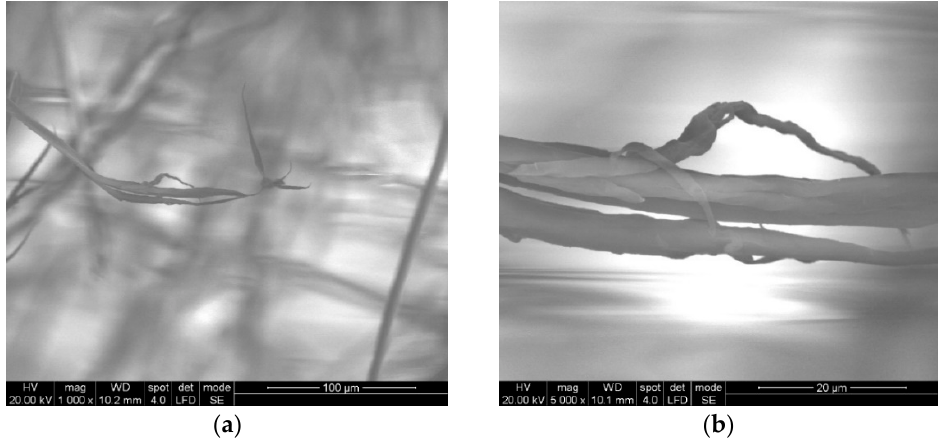
Figure 14. Details of fibers from the ballistic package LFT SB1plus: ( a ) fibril from front layer 2; ( b ) detail from ( a ).